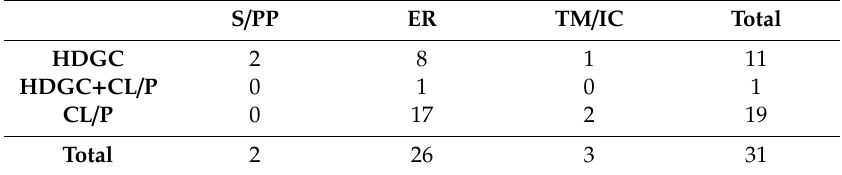
Table 2. Missense and in-frame variants in each phenotypic group by location. S / PP ER TM / IC